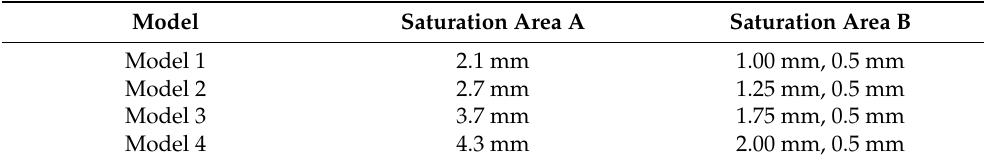
Table 2. Width of magnetic leakage paths in saturation areas A and B.